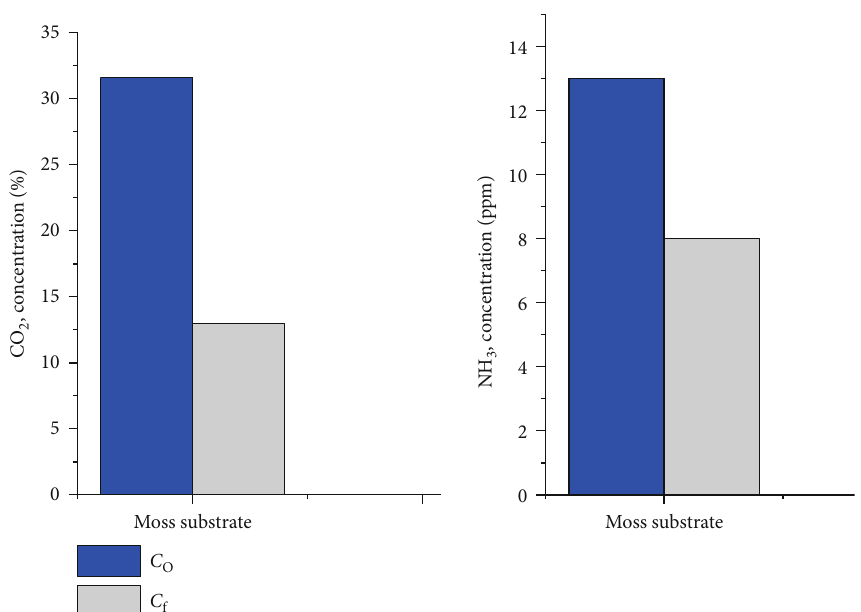
Figure 8: Adsorption of CO time =60